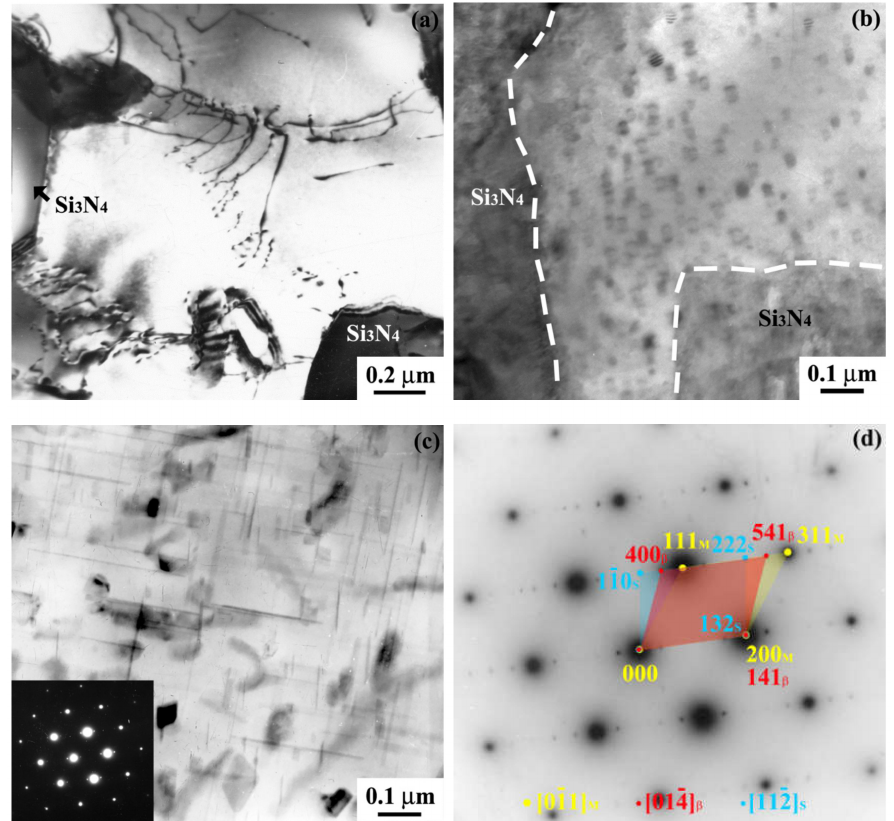
Figure 5. Transmission electron microscopy (TEM) micrographs of Si 3 N 4 w / Al-11.5Si-1.0Mg-0.5Cu-0.5Ni composite: ( a ) As-cast composite; ( b ) Composite after aging for 5 h; ( c ) Composite after aging for 6 h; and ( d ) The corresponding SADP of matrix, S-Al 2 CuMg and β -Mg 2 Si phases in ( c ).